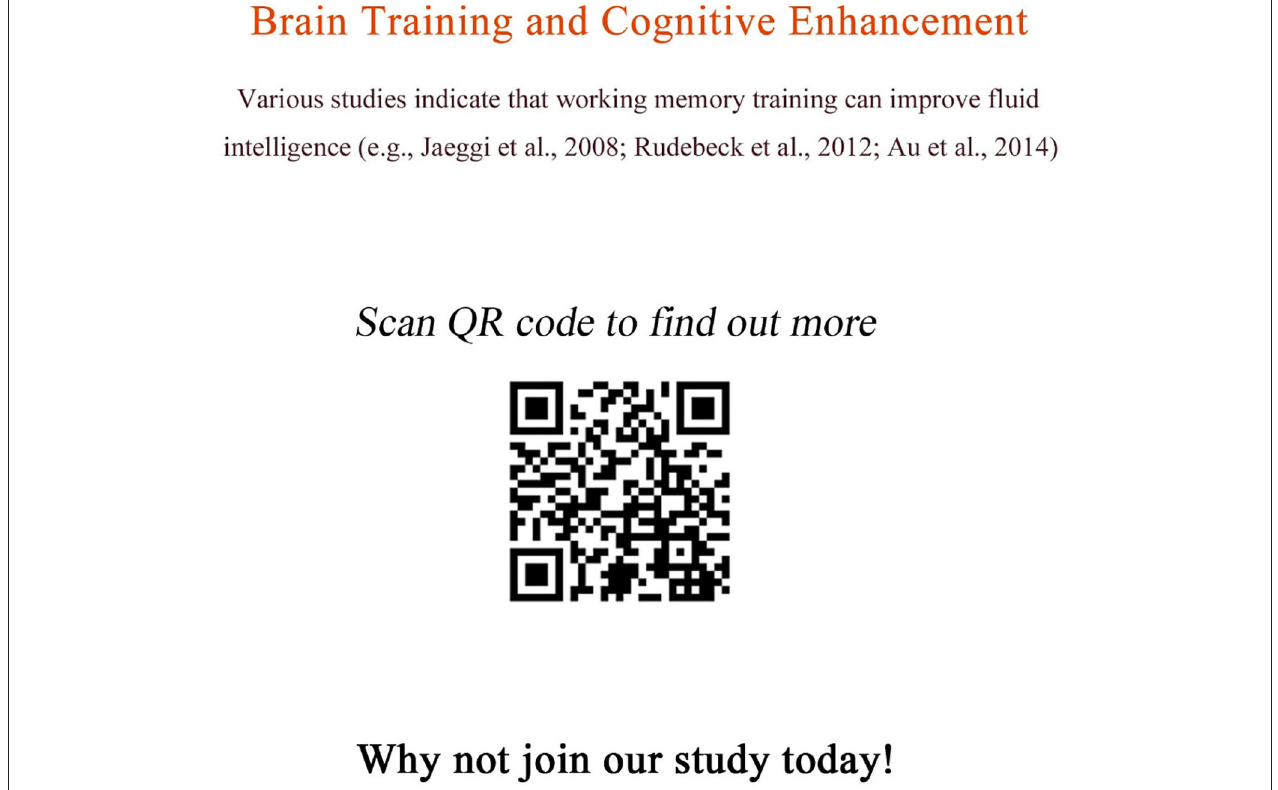
FIGURE 1 | Poster (the original poster was in Chinese).